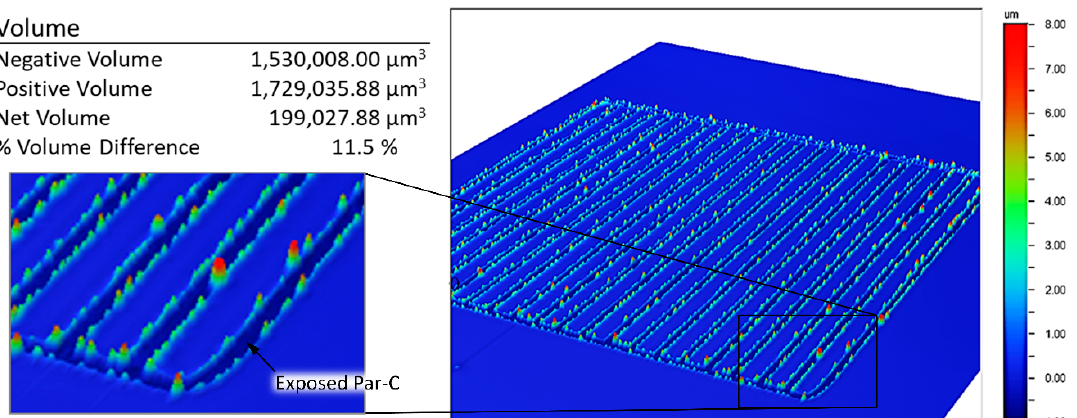
Figure 3. 3D profilometry mapping of a Ni linear array formed by directed dewetting with a spacing of 100 µ m. “Negative” and “Positive” relate to the surface of the original Ni film. Of the accounted volume, an 11.5% excess positive volume remains unaccounted for after the dewetting process. This is attributed to shadowing effects from the measurement and the shape of the features.